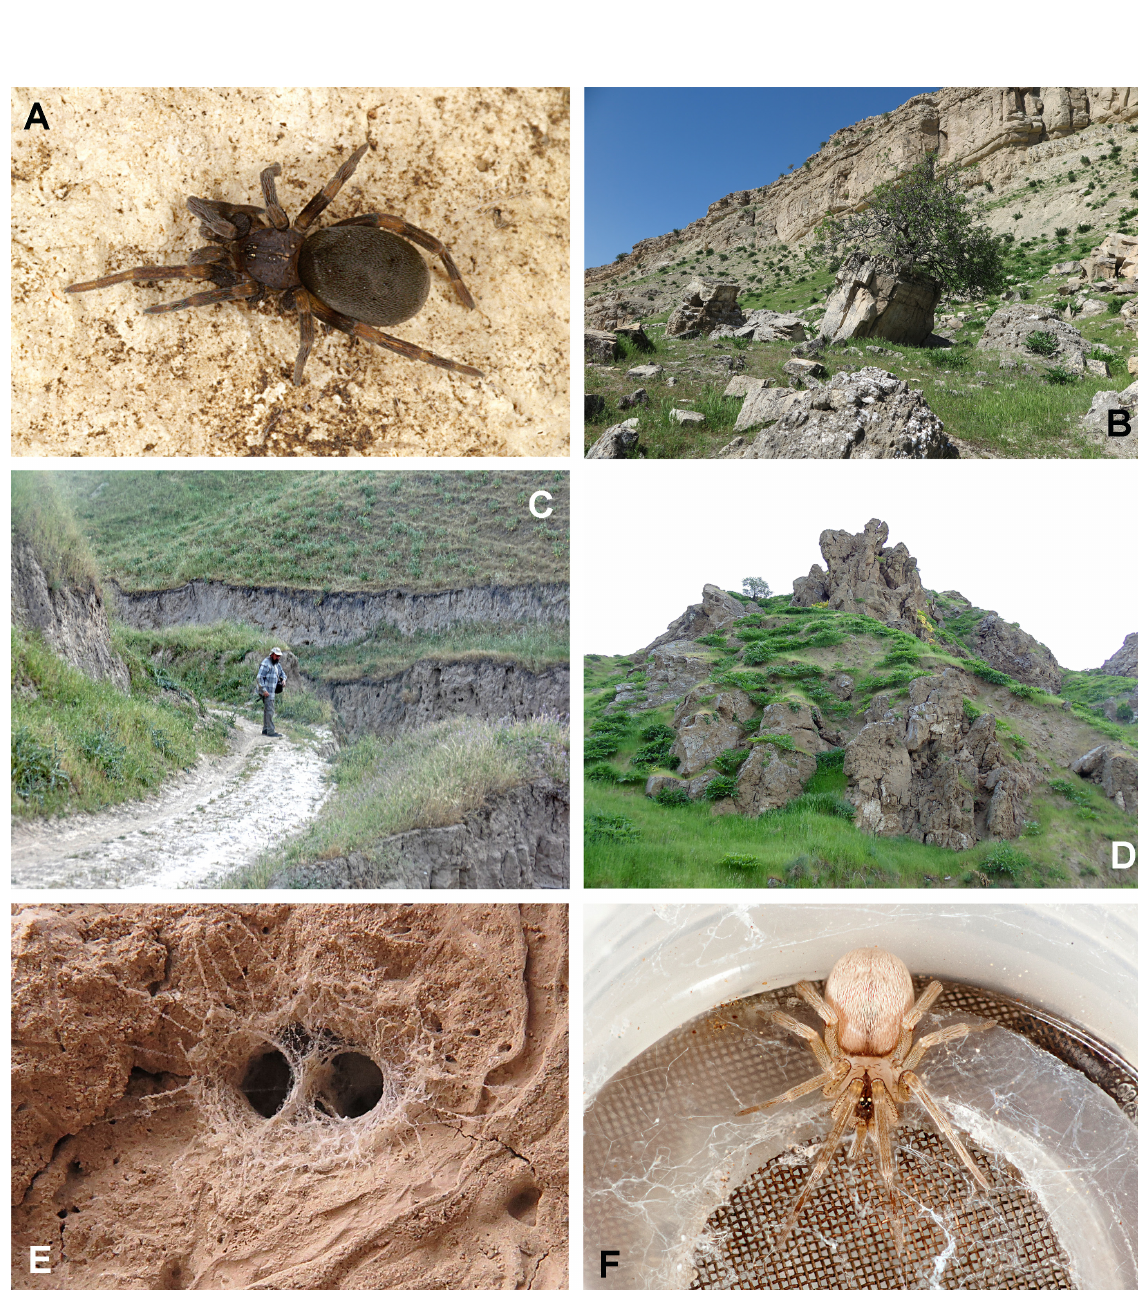
Fig. 50. Live specimens of Zaitunia and habitats of Z. martynovae (Andreeva & Tyshchenko, 1969) in Southern Tajikistan. A . ♀ of Z. schmitzi (Kulczyński, 1911) on the turned stone bottom (Israel, Shoham, image courtesy of Amir Weinstein). B . Surroundings of Gandzhina: the spiders occur under the stones. C . Pyandzh-karatau Mts, one of the co-authors (YM) near the clay escarps inhabited by filistatids. D . Foothills of the salt dome khodzha-Mumin: the spiders inhabit crevices and cavities in the rock outcrops. E . One of the figured escarps, a close-up photo showing the twin entrance leading to the inhabited cavity . F . Captured ♀ of Z. martynovae (Andreeva & Tyshchenko, 1969) weaving a web in the cover of a collecting